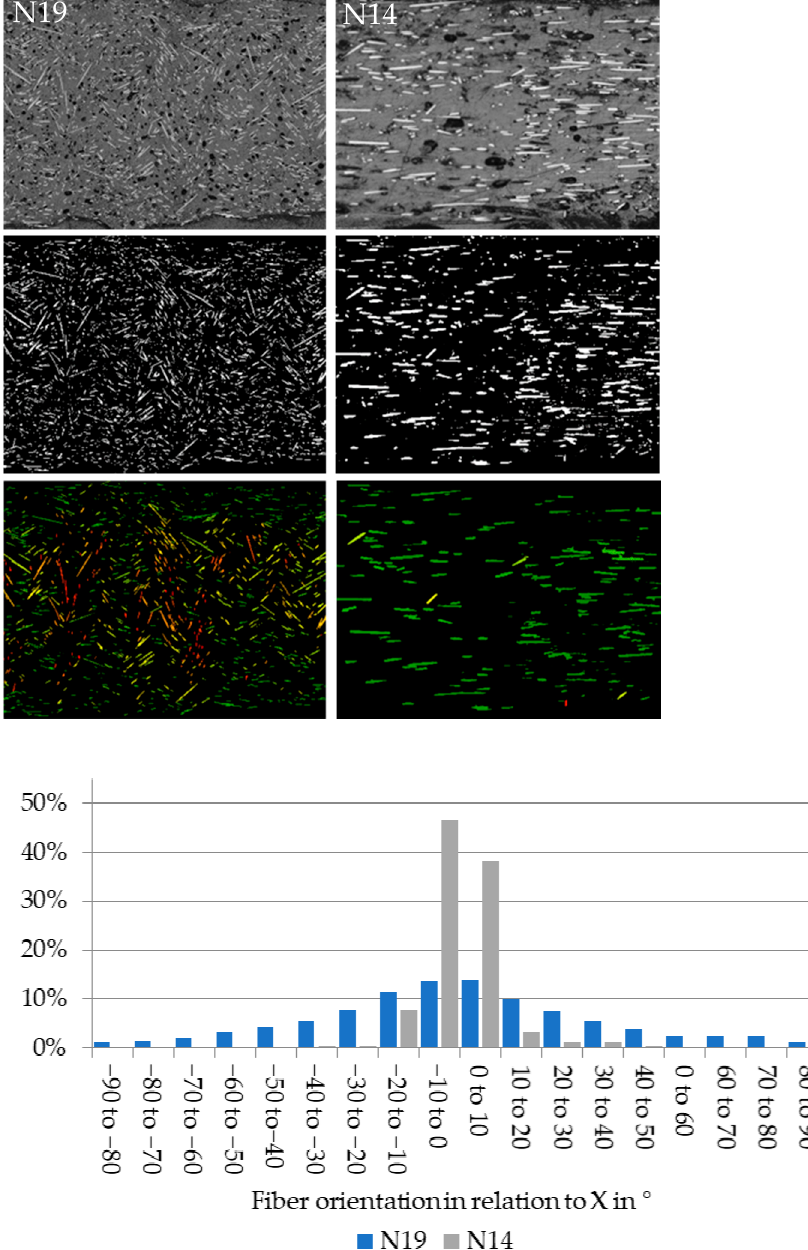
Figure 8. Top: Steps in measuring the fiber orientation, grayscale, binary and color-coded by orientation: Left: N19#2 with a high fiber misalignment of 34.7 ◦ , measured in 1986 detected fibers in the image; Right: N14#3 with high fiber alignment of 9.5 ◦ , measured in 181 detected fibers; Bottom: the resulting fiber orientation distributions.